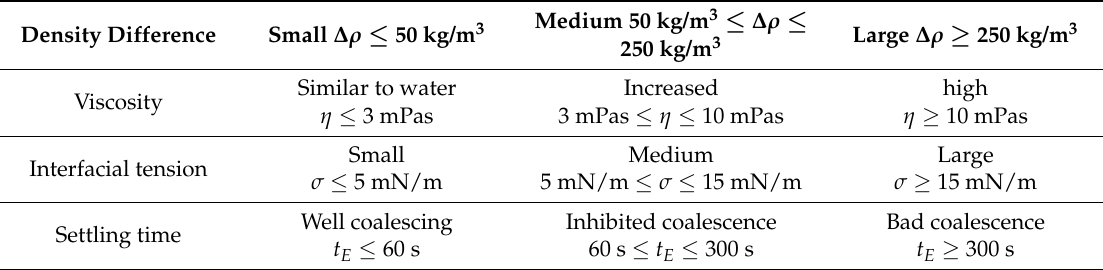
Table 3. Ranges for important properties for liquid-liquid-extraction